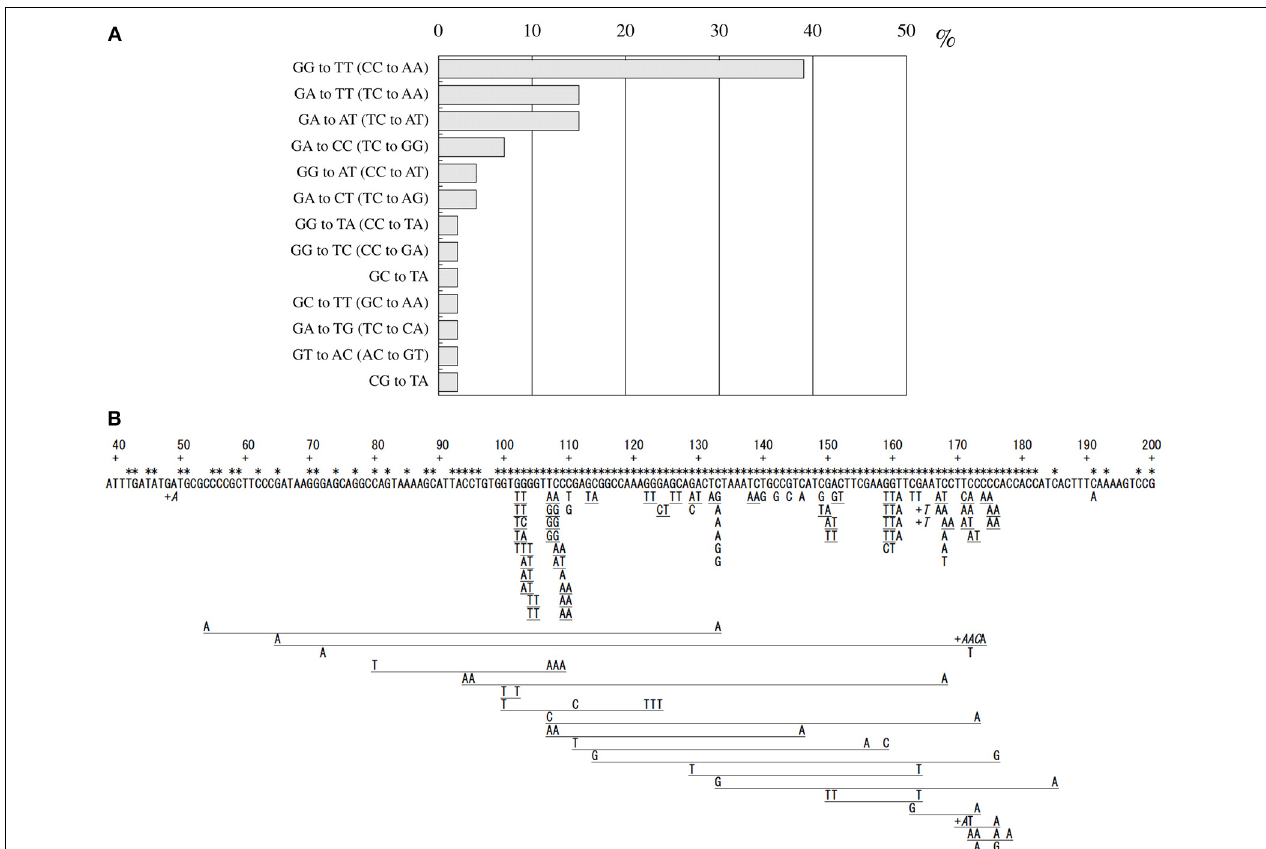
FIGURE 4 | Classification of formaldehyde-induced tandem base substitution mutations (A), and Location of formaldehyde-induced base substitution and frameshift mutations in sup F gene (B). Method : Mutated plasmids were extracted and purified, and the size of each plasmid was checkedbyagarosegelelectrophoresis.Thenucleotidesequencesofthe supF gene of the plasmids of a normal size were determined with the ABI DNA